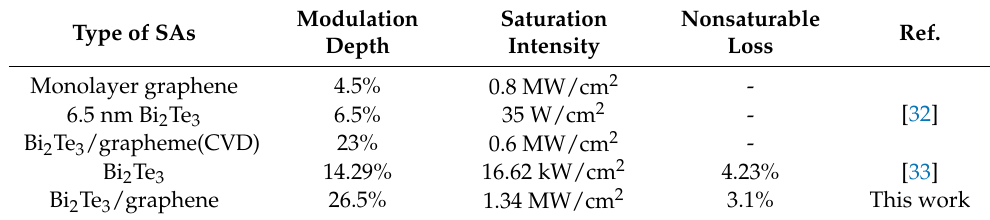
Figure 4. ( a ) Z-scan curve and ( b ) nonlinear saturable absorption curve of Bi 2 Te 3 /graphene AS. Table 1. Nonlinear absorption parameters of graphene SA, Bi 2 Te 3 SA, and graphene/Bi 2 Te 3 SA.